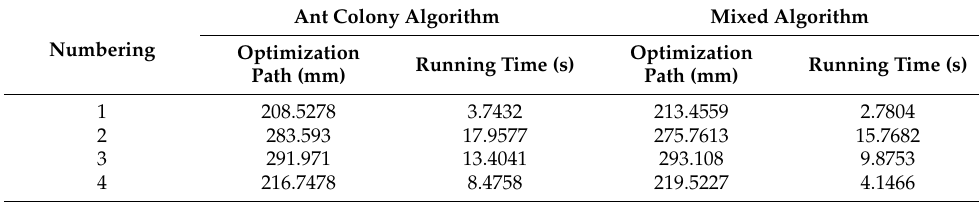
Table 7. Algorithm comparison.